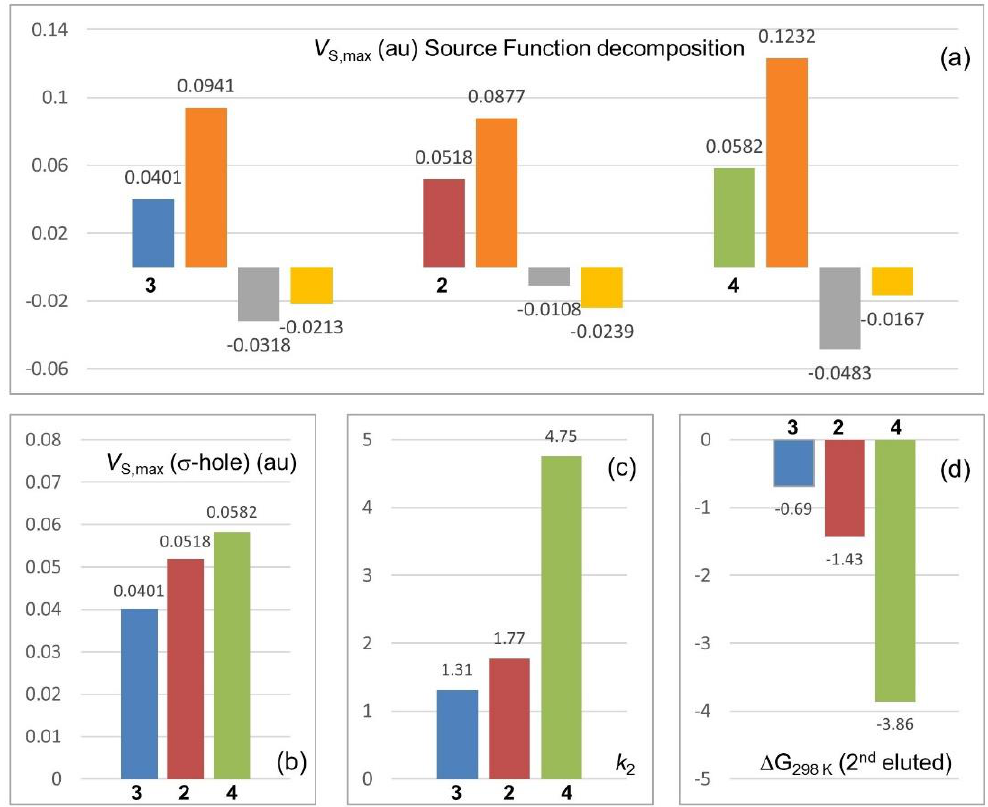
Figure 8. ( a ) V S,max (au) source function (SF) decomposition in three σ -hole cases (compounds 2 , 3 , and 4 ) [9], data refer to the C pyridyl –Se σ -holes, contribution colors: Se (orange), R (grey), Bipy (yellow); ( b ) V S,max (au) associated with the C pyridyl –Se σ -holes of compounds 2 – 4 , ( c ) trend of k 2 , and ( d ) ΔG° 298 K for the second eluted enantiomers of compounds 2 – 4 .